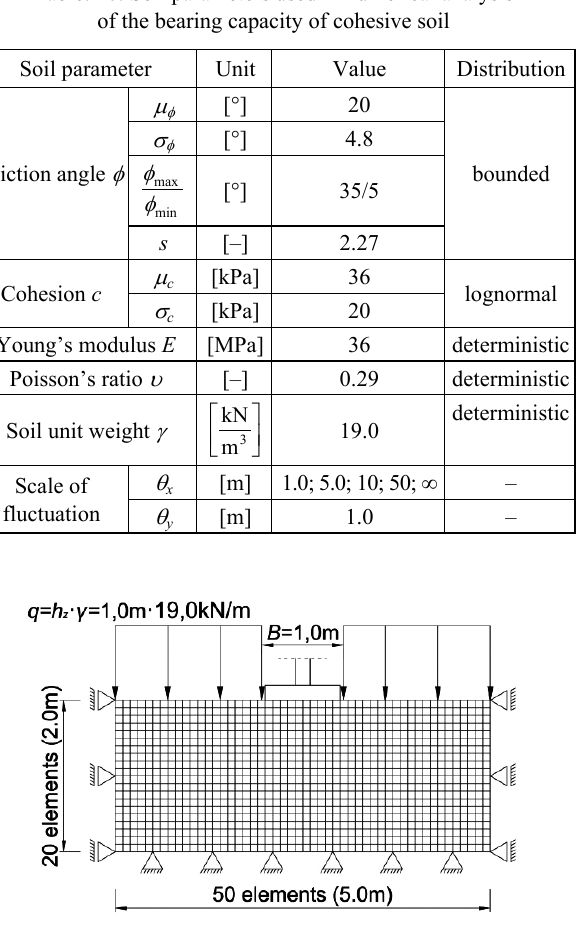
Fig. 9. The soil model used in numerical analysis of the bearing capacity of cohesive